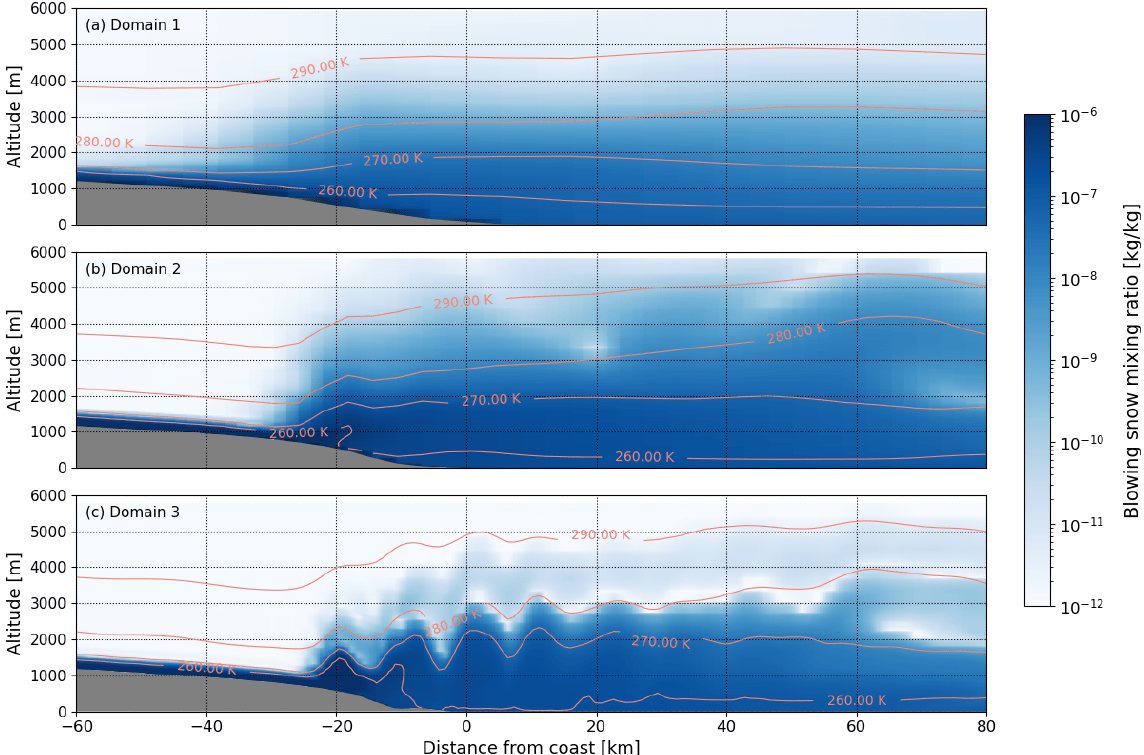
Figure 12. Blowing snow mixing ratio. Vertical cross sections at the transect through DDU indicated by the dashed red line in Fig. 11 on 10 August 2017 at 12:00UTC for the three domains with (a) 12km, (b) 4km and (c) 1km resolution. Four potential temperature contours are indicated (orange). Note that the colour bar is